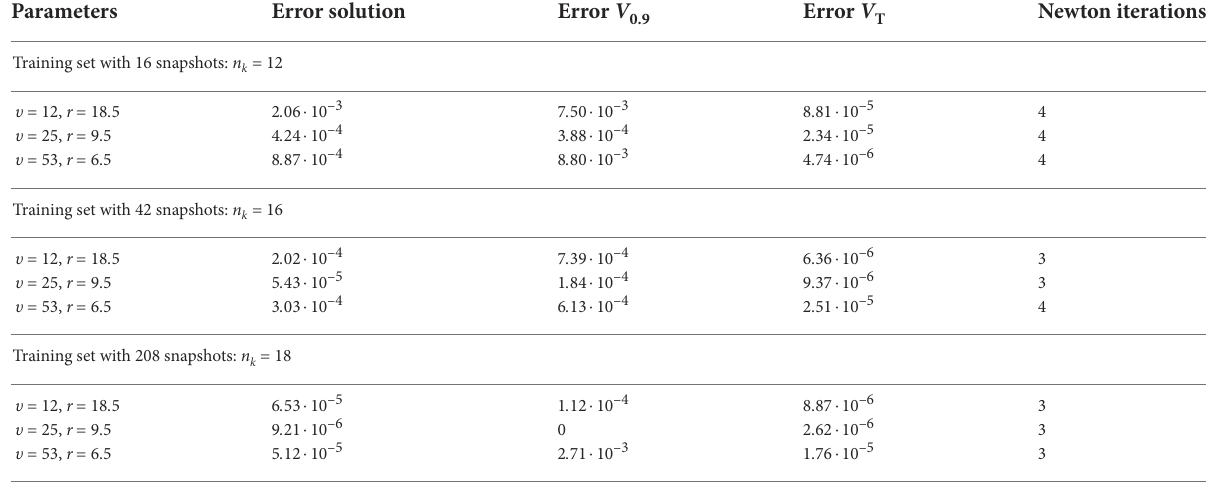
TABLE 1 RelativeerrorsandnumberofNewtoniterationsofstandardPODwhensolvingtheBVPin(Eq. 1).Trainingsetswith16,42and208snapshotsare usedtoapproximatesolutionsforparameters ( υ , r ) = ( 12 , 18 . 5 ) ( 25 , 9 . 5 ) and ( 53 , 6 . 5 ) .ThetruncationtoleranceinPODis ɛ = 10 –3 ,andthetolerancefor convergenceintheNewtonschemeis 10 –6 . Parameters Error solution Error V